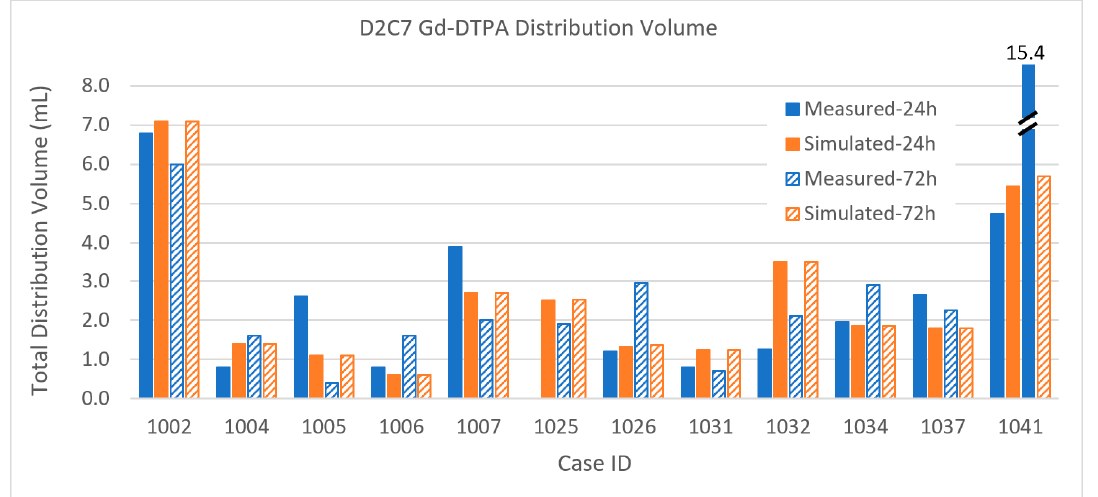
Figure 12. Comparison of measured and simulated Gd-DTPA in D2C7 patients. All of these patients